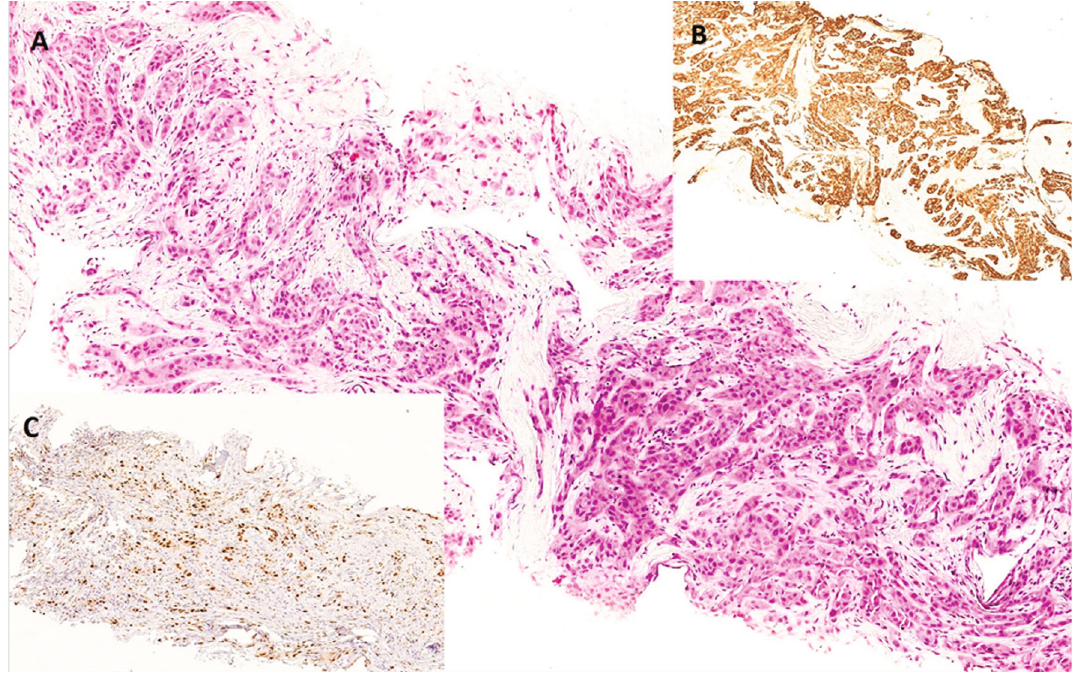
Figure 1: Diagnostic biopsy in case 1 (a) staining with hematoxylin and eosin; the epithelial origin is con fi rmed by the positivity to high MW cytokeratin (b); the proliferative index, evaluated with the MIB-1 clone of the Ki-67 antibody, highlights the malignant nature of the lesion with high proliferation